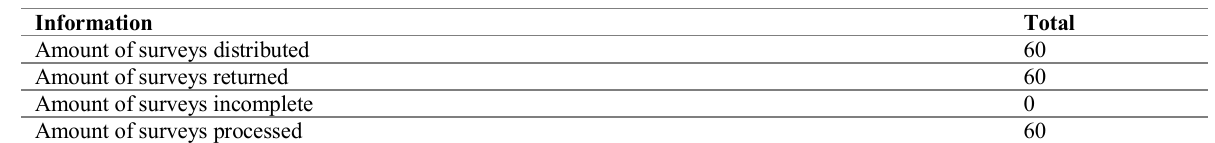
Table 1. Survey Results